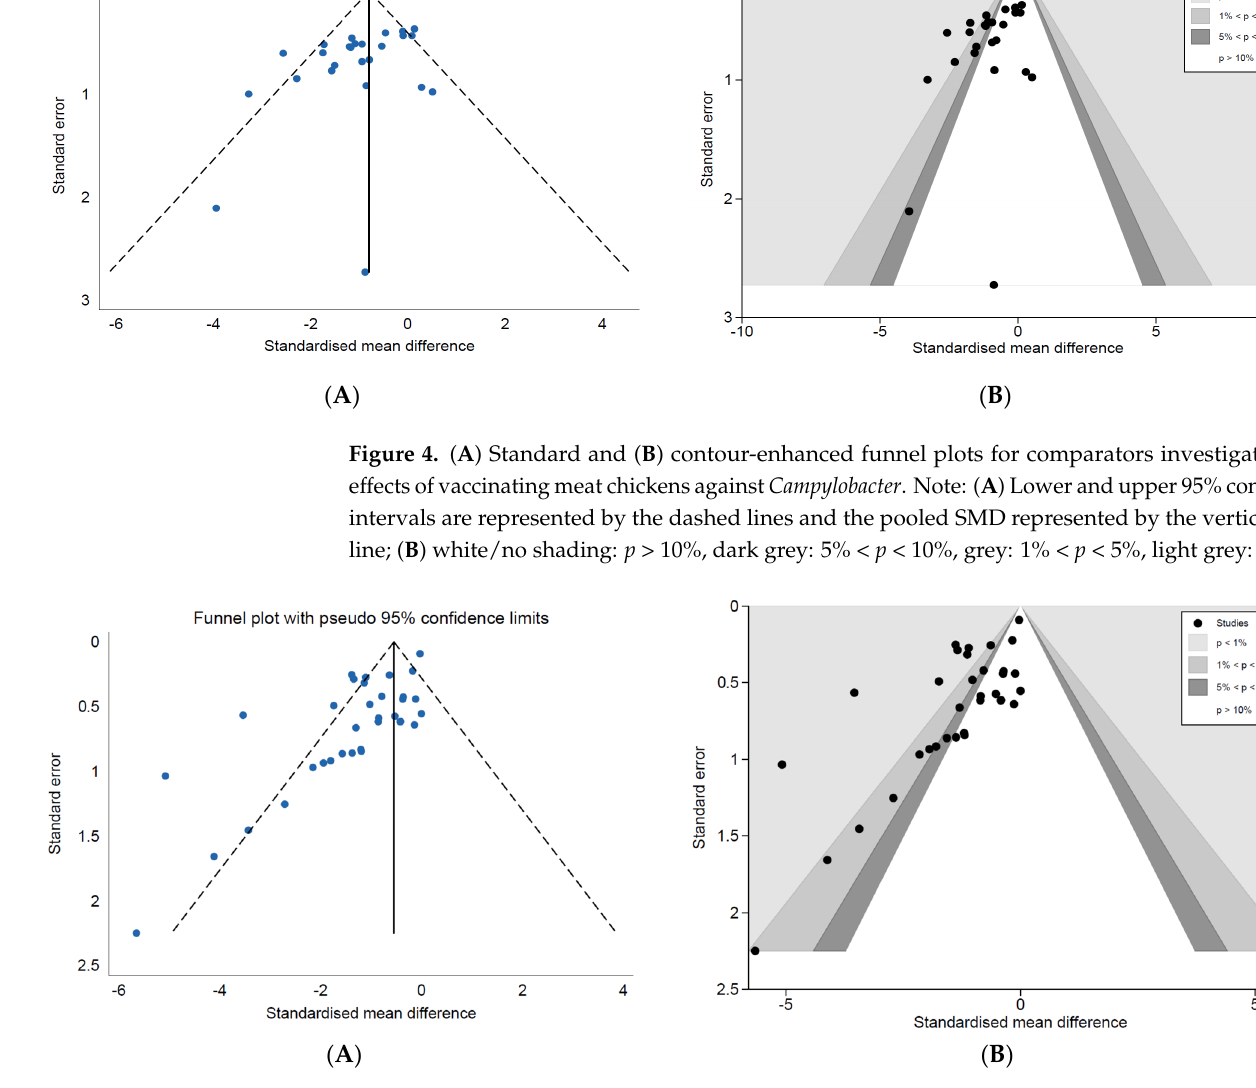
Figure 5. ( A ) Standard and ( B ) contour-enhanced funnel plots for comparators investigating the effects of vaccinating meat chickens against Salmonella. Note: ( A ) Lower and upper 95% confidence intervals are represented by the dashed lines and the pooled SMD represented by the vertical solid line; ( B ) white/no shading: p > 10%, dark grey: 5% < p < 10%, grey: 1% < p < 5%, light grey: p < 1% .